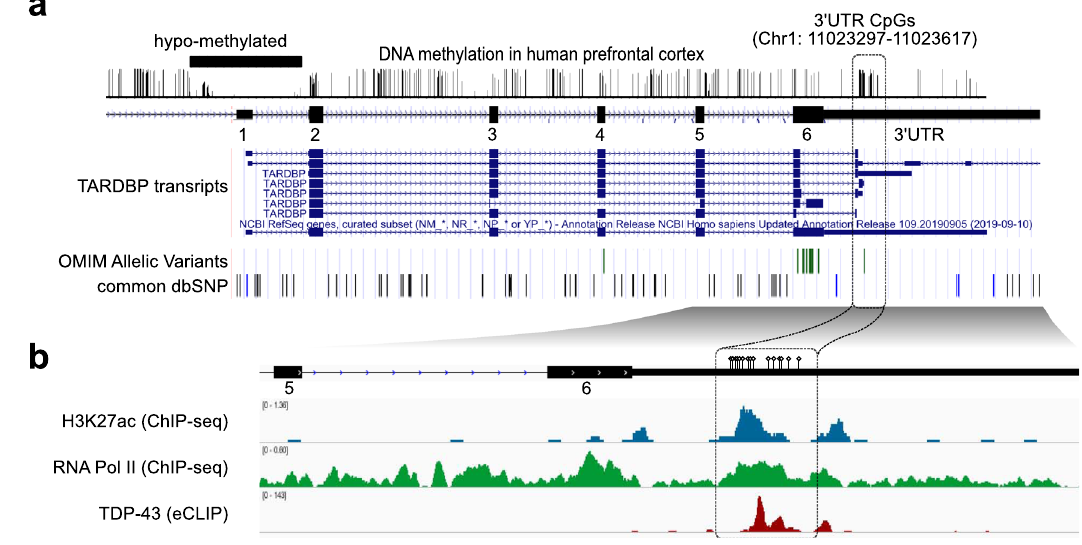
Fig. 1 TARDBP 3 ′ UTR CpG sites. a The TARDBP DNA methylation status in the human prefrontal cortex obtained from MethBase. TARDBP transcripts, ALS-causing gene variants (OMIM allelic variants), and SNP positions as indicated in the Single Nucleotide Polymorphism Database (dbSNP) were determined with the UCSC Genome Browser on Human Dec. 2013 (GRCh38/hg38) Assembly. b CpG (circles) located around the 5 ′ site of intron 7 in magni fi ed views of exons 5, 6 and 3 ′ UTR, ChIP-seq data of H3K27ac (SRX2161995) and RNA polymerase II (SRX100455) in K562 cells as indicated by ChIP-Atlas and eCLIP data of TDP-43 in K562 cells from the ENCODE database